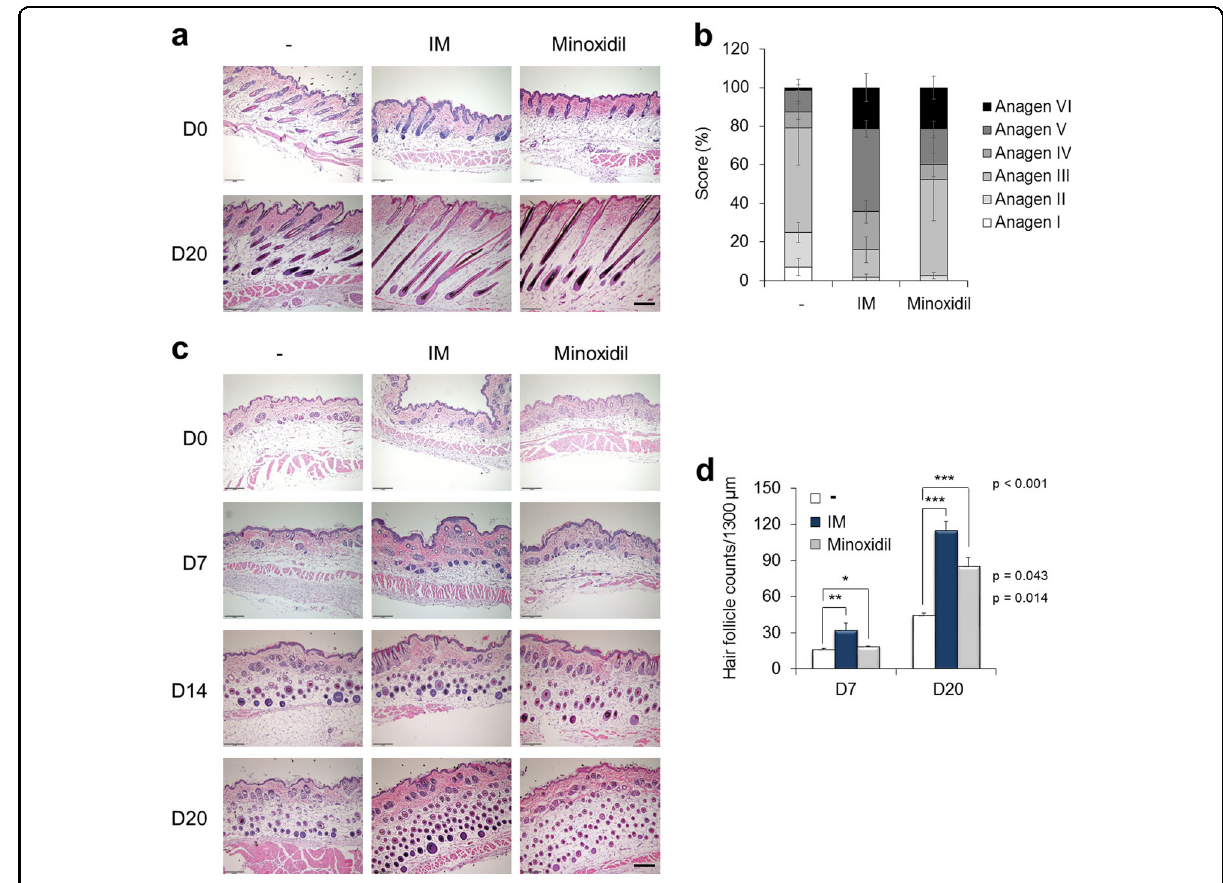
Fig. 4 IM facilitates the cycle of hair follicle regeneration in mice. a Representative images of H&E-stained longitudinal sections of each treated mouse skin on days 0 and 20 after depilation. b Progression of the hair follicle cycle on day 20 was quantitatively evaluated. Individual hair follicles were classi fi ed based on the classi fi cation by Chase. c Representative images of H&E-stained transverse sections of each treated mouse skin on days 0, 7, 14, and 20 after depilation. d Hair follicles were counted on days 7 and 20. * p < 0.05; ** p < 0.01; *** p < 0.001 (Student ’ s t -test). Scale bar = 200 μ